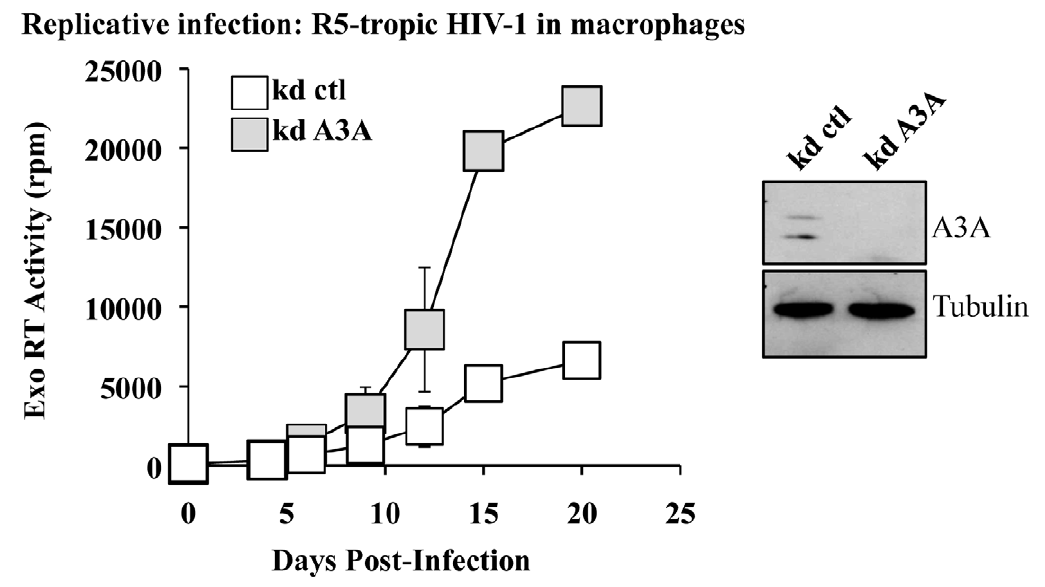
Figure 4. A3A silencing increases viral spread of an R5 tropic HIV-1 virus in macrophages. Macrophages stably silenced as above were infected with an R5 tropic HIV-1 virus (Yu2) at an MOI of 0,05. Viral spread was determined by exo-RT. The graph presents data obtained from 4 independent experiments, while the WB panels present the efficacy of A3A silencing at day 15 in one representative experiment.